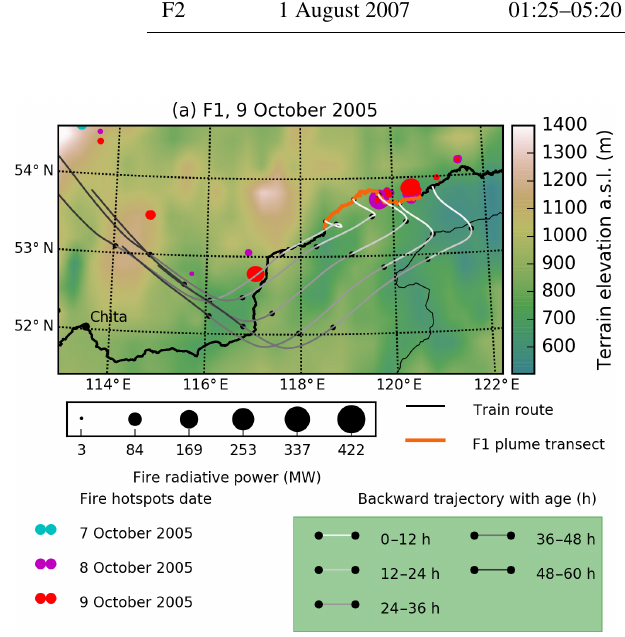
Figure 2. Same as Fig. 1 but for the F2 plume. The train course is from east to